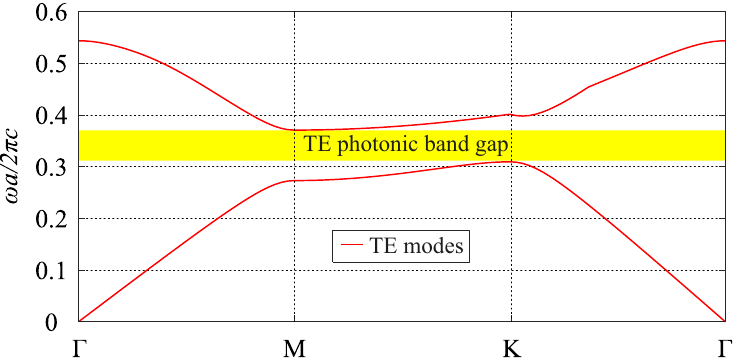
Figure 1. Dispersion relation of the PhC structure for TE modes (only the first and second bands are shown).